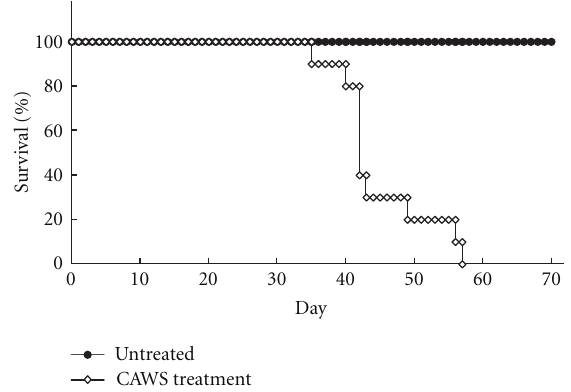
Figure 1: Kaplan-Meier analysis of CAWS arteritis in DBA/2 mice. CAWS treatment DBA/2 mice were administered with CAWS one mg/mouse via peritoneal injections for five consecutive days. DBA/2 mice at four or five weeks of age were maintained in specific pathogen free (SPF) conditions and observed every day. All CAWS treatment mice died between five and eight weeks after treatment. P < 0 . 005 for survival of untreated versus CAWS treatment mice at six weeks after the CAWS treatment; n = 8 (control) and n = 10 (CAWS